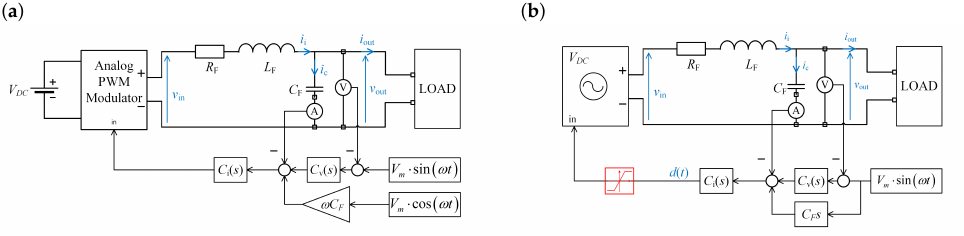
Figure 1. ( a ) Schematic diagram of a double-loop analog control system with the capacitor current feedback and an analog PWM modulator, ( b ) continuous-time model with one reference input according to [14,17,21–23]. R F is the ESR of the